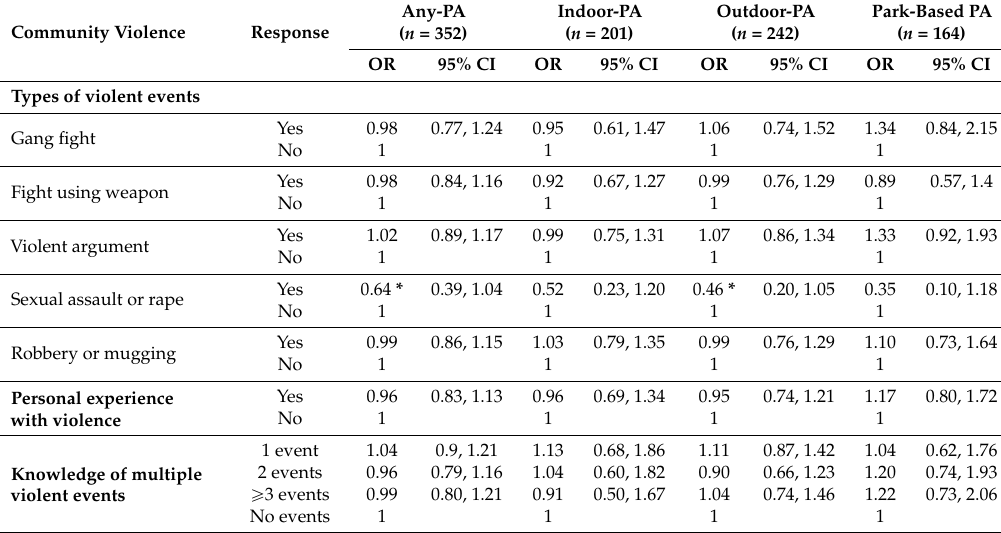
Table 5. Adjusted odds ratios between participant reports of community violence and physical activity (PA) a .